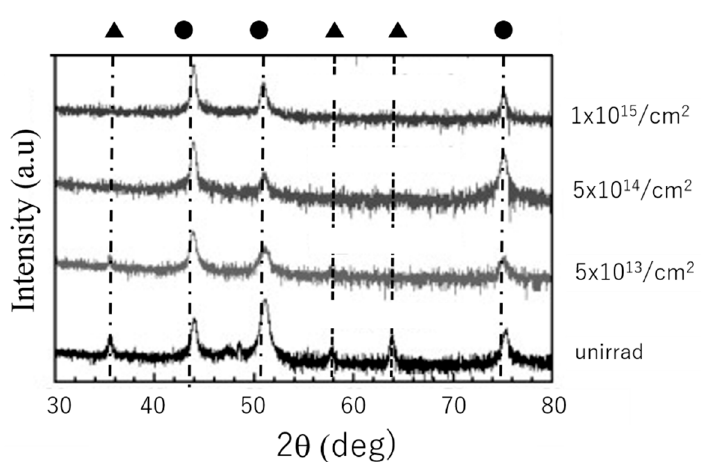
Figure 21. GIXD spectra for unirradiated Ni 3 Al and 16MeV Au ion-irradiated Ni 3 Al. Ion fluences are shown at the right side of the figure. Solid triangles for L1 2 superlattice peaks and solid circles for A1 fundamental peaks.